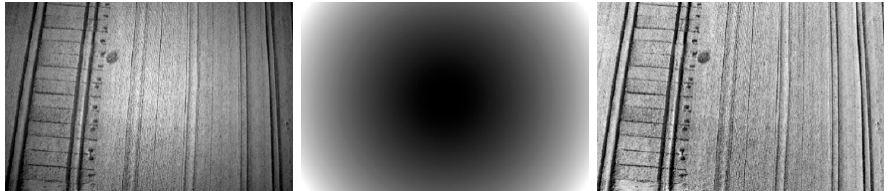
Figure 4. The input NIR image ( left ), generated vignetting filter ( middle ) and vignetting corrected image ( right ).